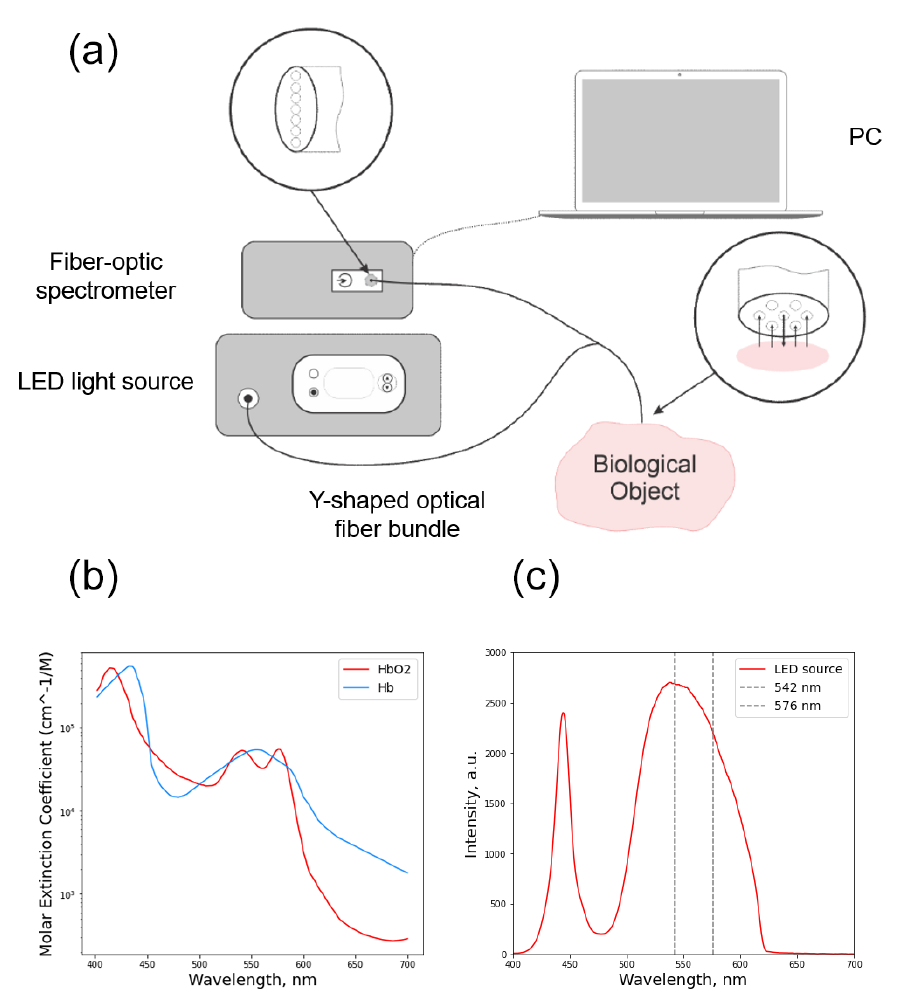
Figure 1. ( a ) The experimental setup, consisting of a source of broadband light radiation, a spec- trometer, an optical Y-shaped fiber bundle and a PC. The optical Y-shaped fiber bundle consists of 7 monofibers: 1 fiber for emitting and 6 for receiving light; ( b ) Absorption spectra of oxyhe- moglobin and hemoglobin; ( c ) Emission spectra of LED source, dashed lines is wavelength of oxyhemoglobin